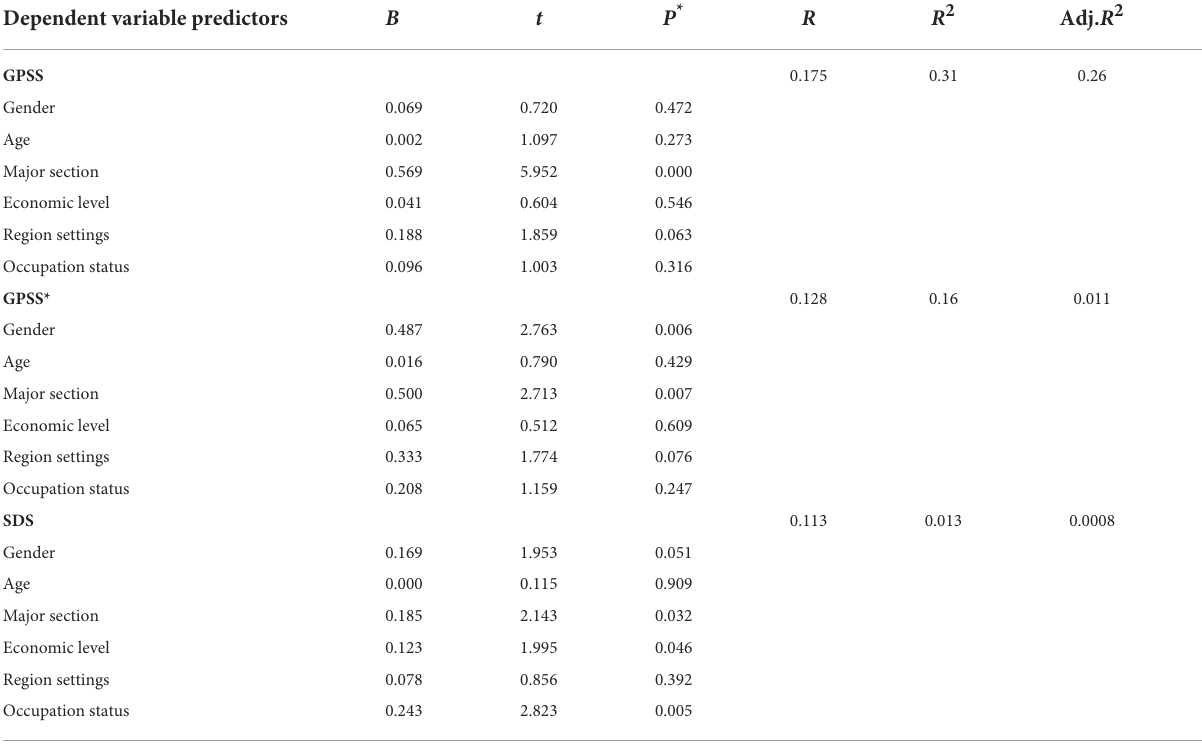
TABLE 5 Predictors for stigma and social distance by multiple linear regression analysis.